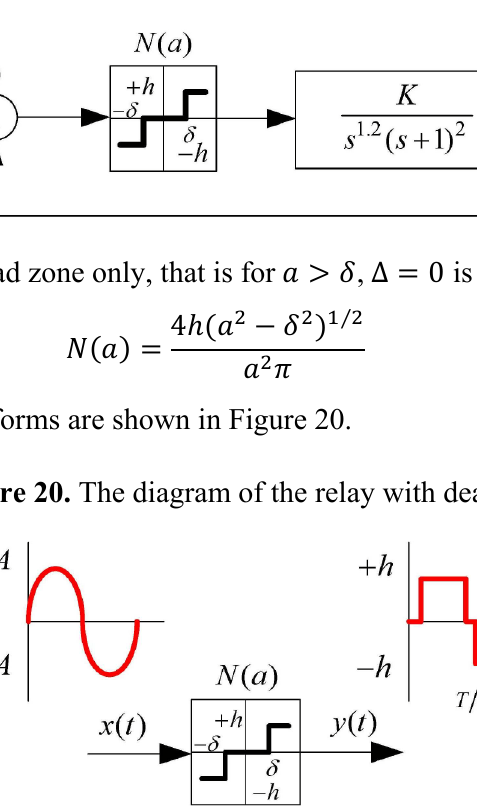
Figure 19. A nonlinear feedback system having relay with dead zone.